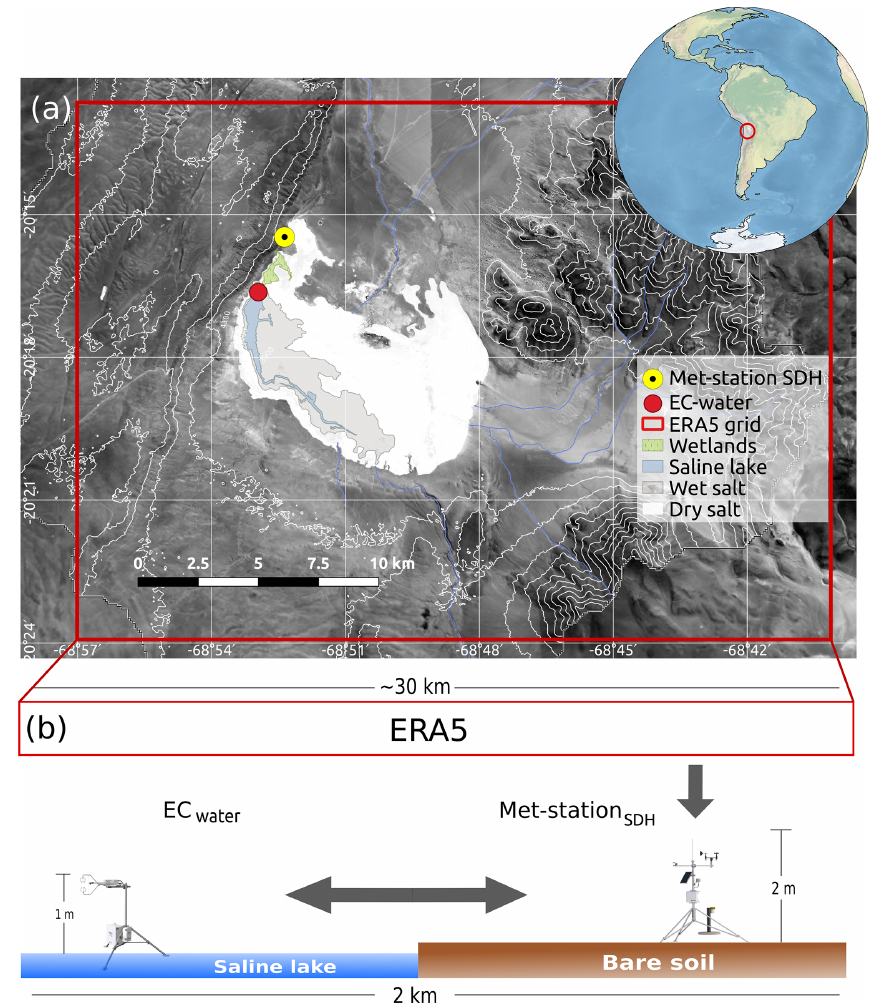
Figure 1. (a) Salar del Huasco (SDH) saline lake and location of the meteorological station and the eddy-covariance (EC) system used in this investigation. The red square shows an approximated grid size of the ERA5 reanalysis data. (b) Schematic cross-section of the meteorological downscaling from larger to smaller spatial scales. It contains modified Copernicus Sentinel data processed by Sentinel Hub,